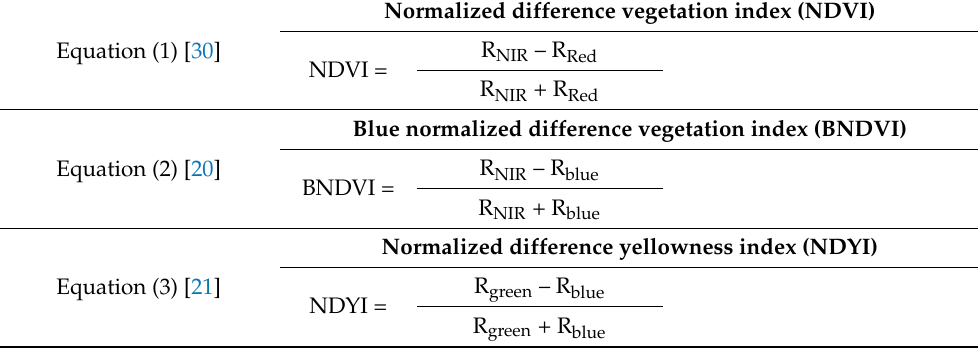
Table 2. Vegetation indices used.